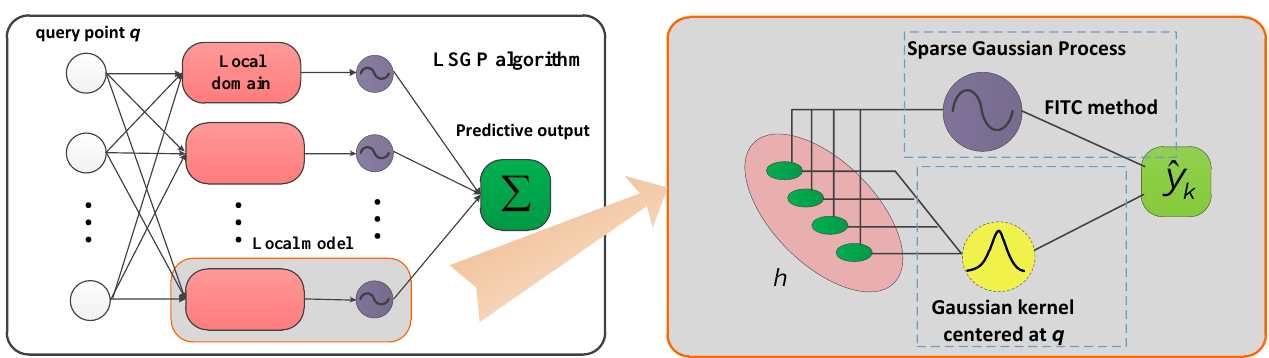
Figure 1. Structure of LSGP identification